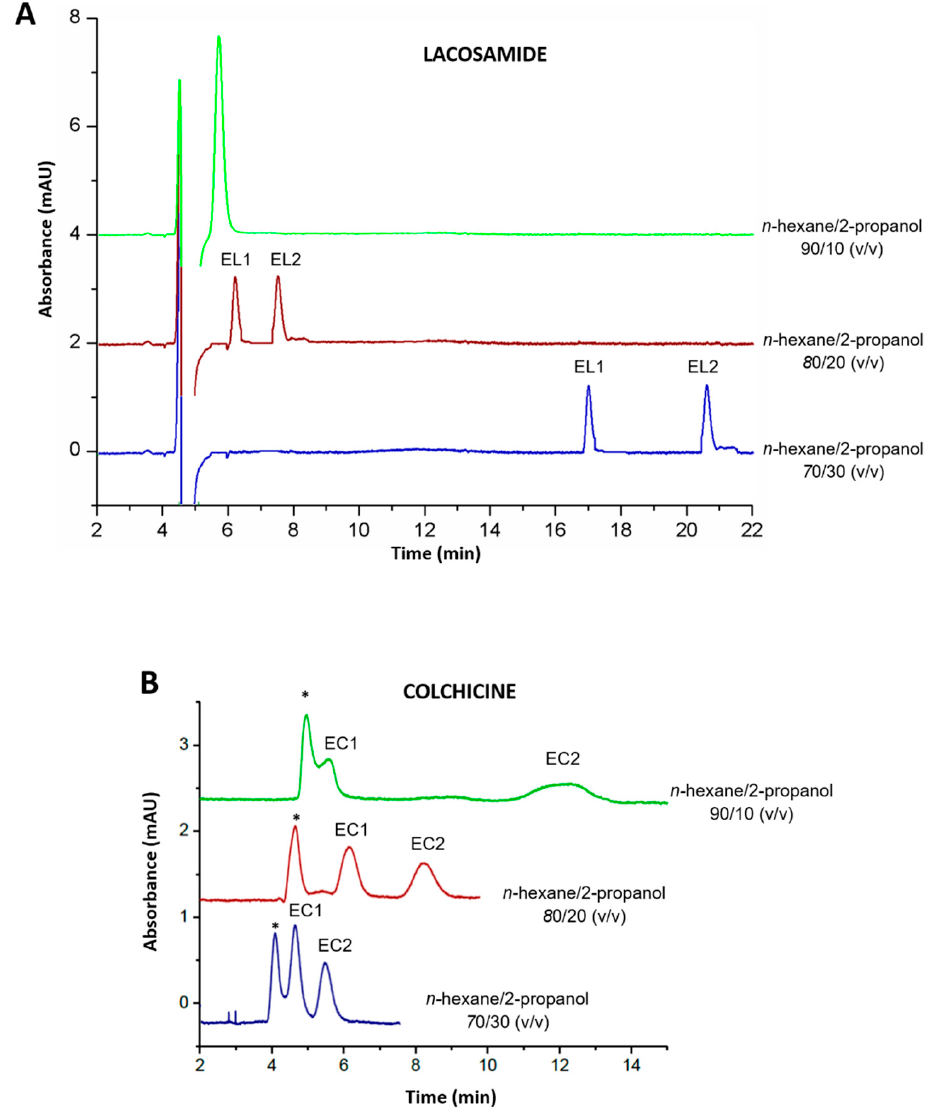
Figure 2. Chromatograms corresponding to the separation of ( A ) a racemic mixture of lacosamide enantiomers (10.0 µ g / mL each enantiomer) and ( B ) a racemic mixture of colchicine enantiomers (12.5 µ g / mL each enantiomer) with di ff erent proportions of n- hexane / 2-propanol in the mobile phase (90 / 10, 80 / 20 and 70 / 30 ( v / v )). Experimental conditions: capillary flow 200 nL / min, λ : 210 nm (lacosamide) and 243 nm (colchicine), room temperature. * Peak corresponding to the solvent signal; EL1: first eluting enantiomer of lacosamide; EL2: second eluting enantiomer of lacosamide; EC1: first eluting enantiomer of colchicine; EC2: second eluting enantiomer of colchicine.